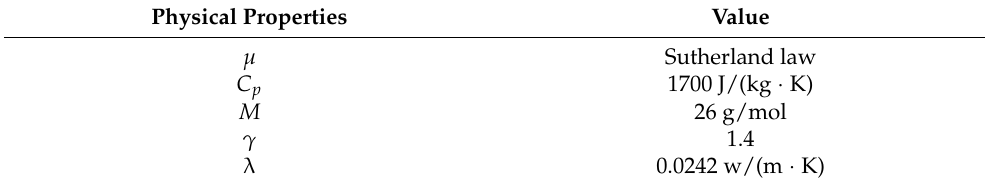
Figure 1. Computational model and boundary conditions in the flow-field simulation. Table 1. Physical properties for the cold flow.